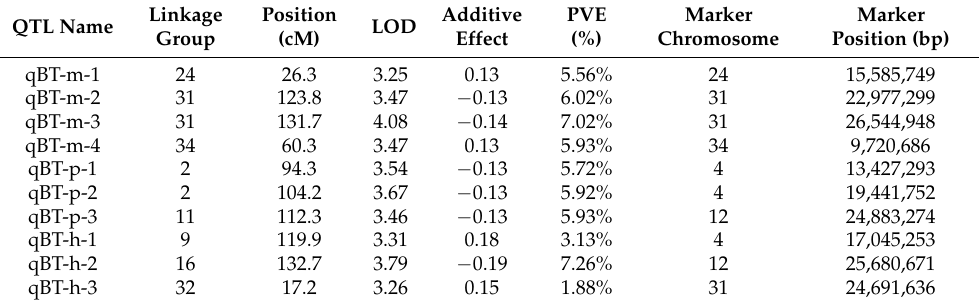
Table 4. Body thickness-associated QTL identified in Yellow River carp 5–17 months after